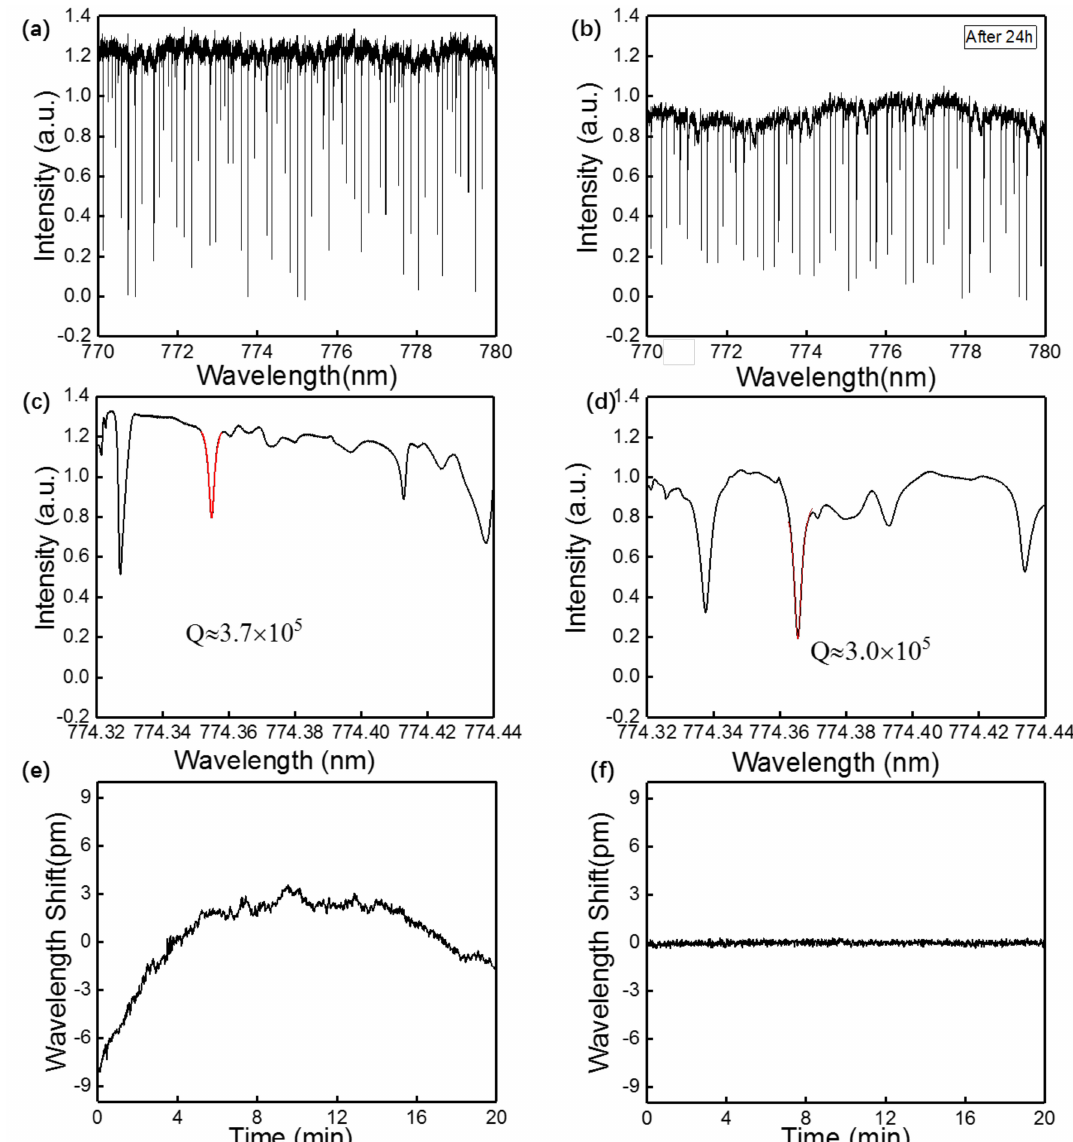
Figure 3. ( a ) Transmission spectra of an OFMBR before packaging in the wavelength range between 770 nm and 780 nm; ( b ) Transmission spectra of an OFMBR 24 h after packaging in the wavelength range between 770 nm and 780 nm; ( c ) Fine scan of the transmission spectra before packaging around 774.3 nm; ( d ) Fine scan of the transmission spectra after packaging around 774.3 nm; ( e ) Resonant wavelength shift of an OFMBR sensor varying with time before packaging; ( f ) Resonant wavelength shift of an OFMBR sensor varying with time after